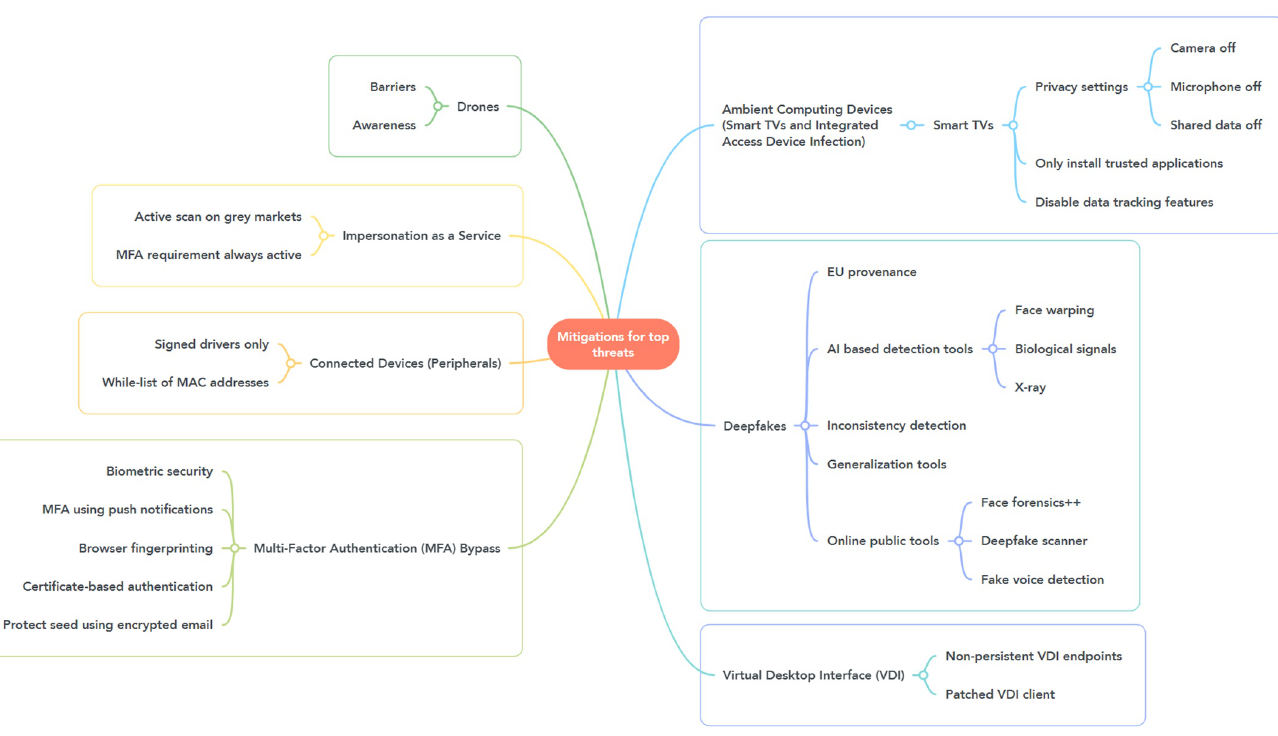
Figure 3. Mitigations for the top